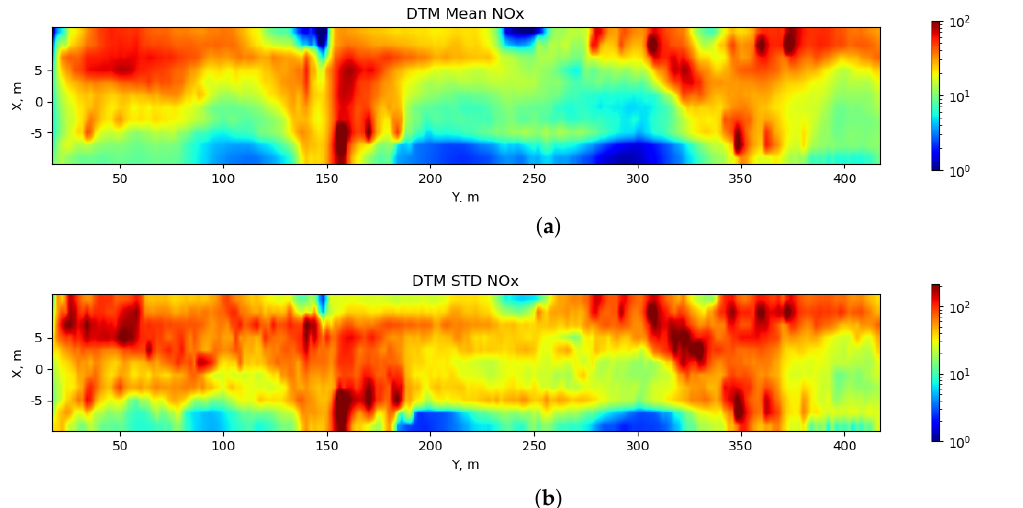
Figure 12. Colour maps of dynamic traffic source concentration (µg/m 3 ) ( a ) mean values and ( b ) standard deviation of 1s signal along the road with wind direction of 40 deg and wind speed of 12 m/s. Values shown at a height of 1m and have been mapped to a 2m resolution